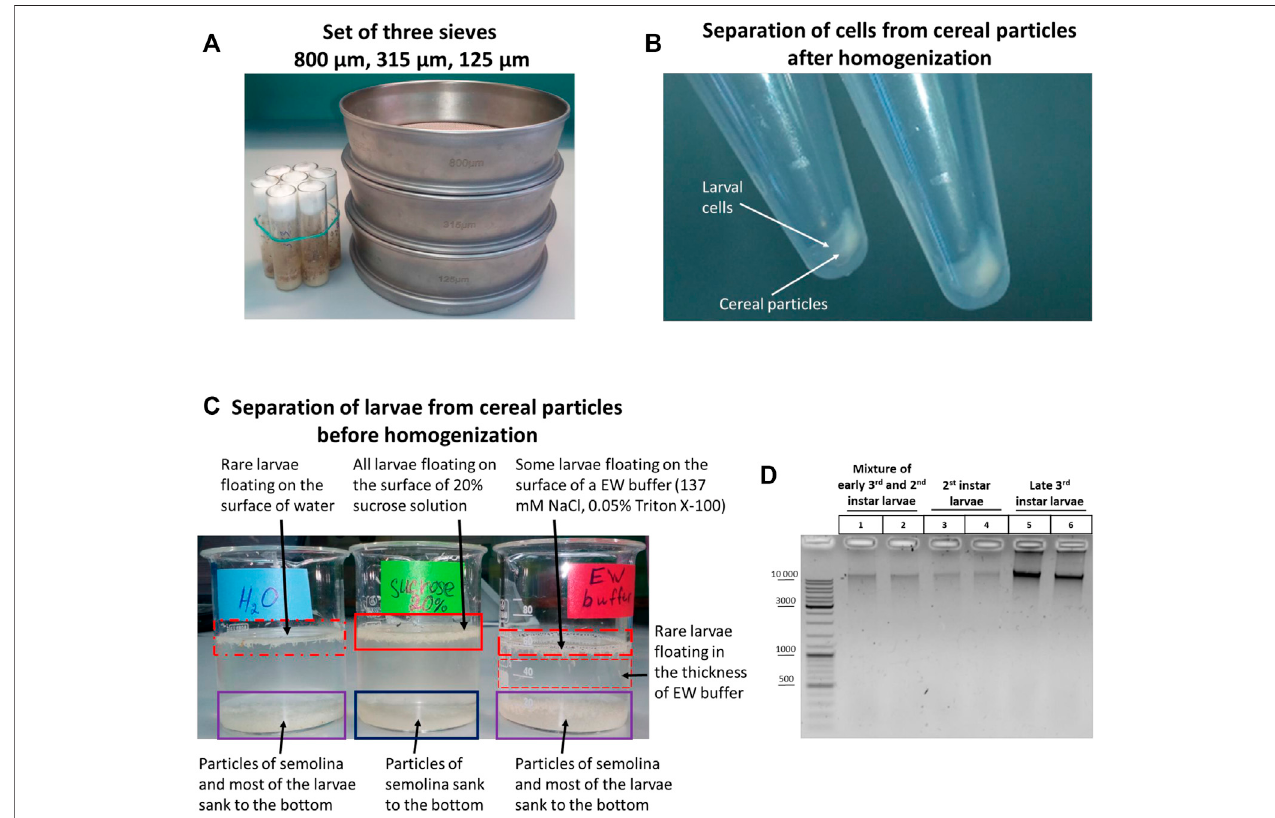
FIGURE 1 | Initial stages of the 3C protocol: collection, sorting, and separation of larvae from fl y food before and after homogenization. (A) TEST SIEVE Retsch GmbH200 mm×50 mm,800 μ m,315 μ m,125 µmincomparisonwithstandardvialsfor Drosophila cultivation. (B) Separationoflarvalcellmaterialfromcerealparticles after homogenization. Total larvae were extracted from fl y food as described in Section 2.1.1. Then the sucrose solution containing the liquid part of the food with the larvae was poured from fl y vials into a set of 3 sieves depicted in Figure 1A , and the larvae were processed to obtain a cell material as described in Processing